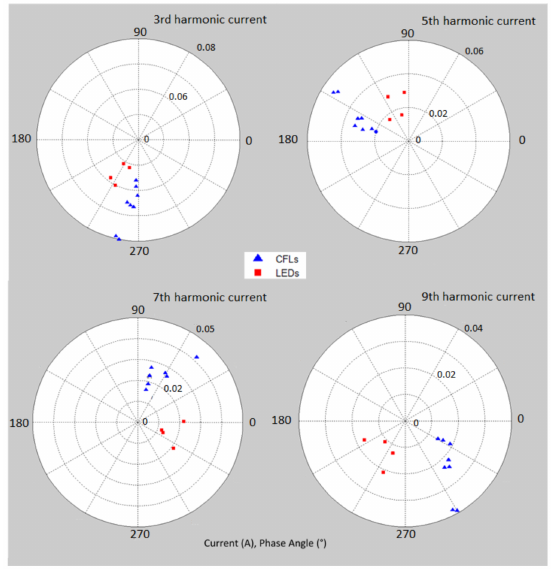
Figure 4. Phase angles of 3rd, 5th, 7th and 9th harmonic currents of LED and CFL lamps.